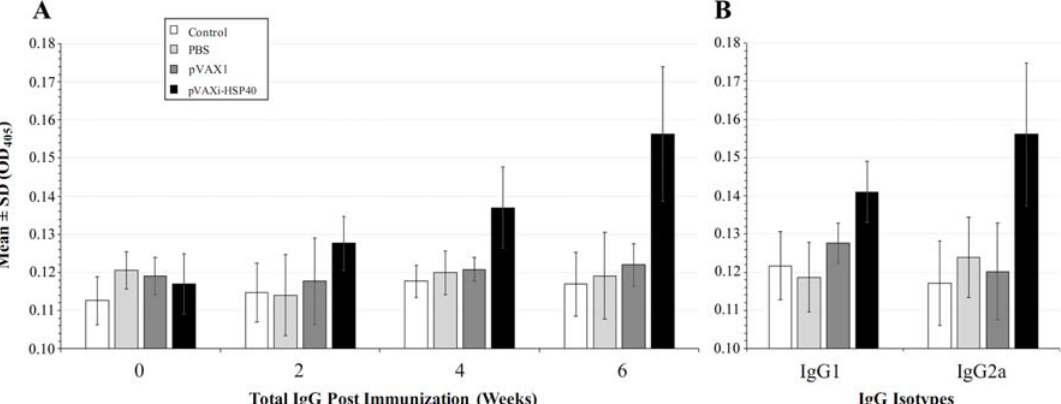
Figure 6. Levels of specific anti-rHSP40 antibodies in the serum of pVAX1-HSP40-immunized mice. (A) The optical densities (OD 405 ) of total IgG prior to each of the three booster immunizations at 0, 2 and 4 weeks, and prior to the challenge at 6 week (i.e., two weeks after the third immunization) using ELISA. (B) Levels of IgG isotypes, IgG1 and IgG2a, two weeks after third immunization (i.e., 6 weeks after the primary immunization). There was no significant difference in the level of antibodies between immunized and control mice ( p >